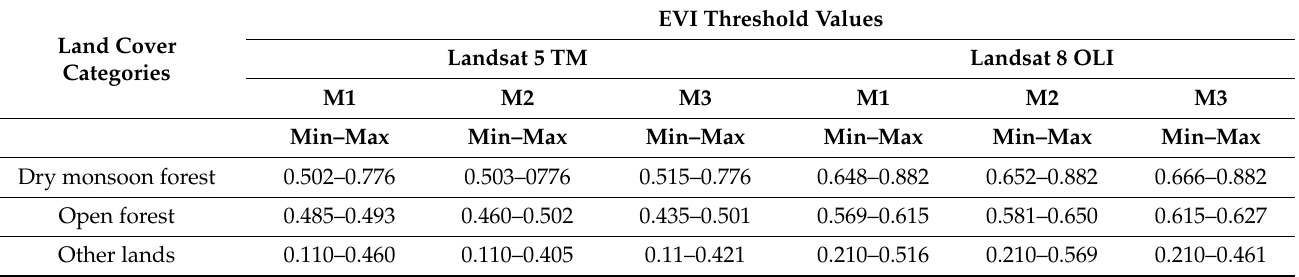
Table 8. M1, M2, and M3 EVI threshold values.